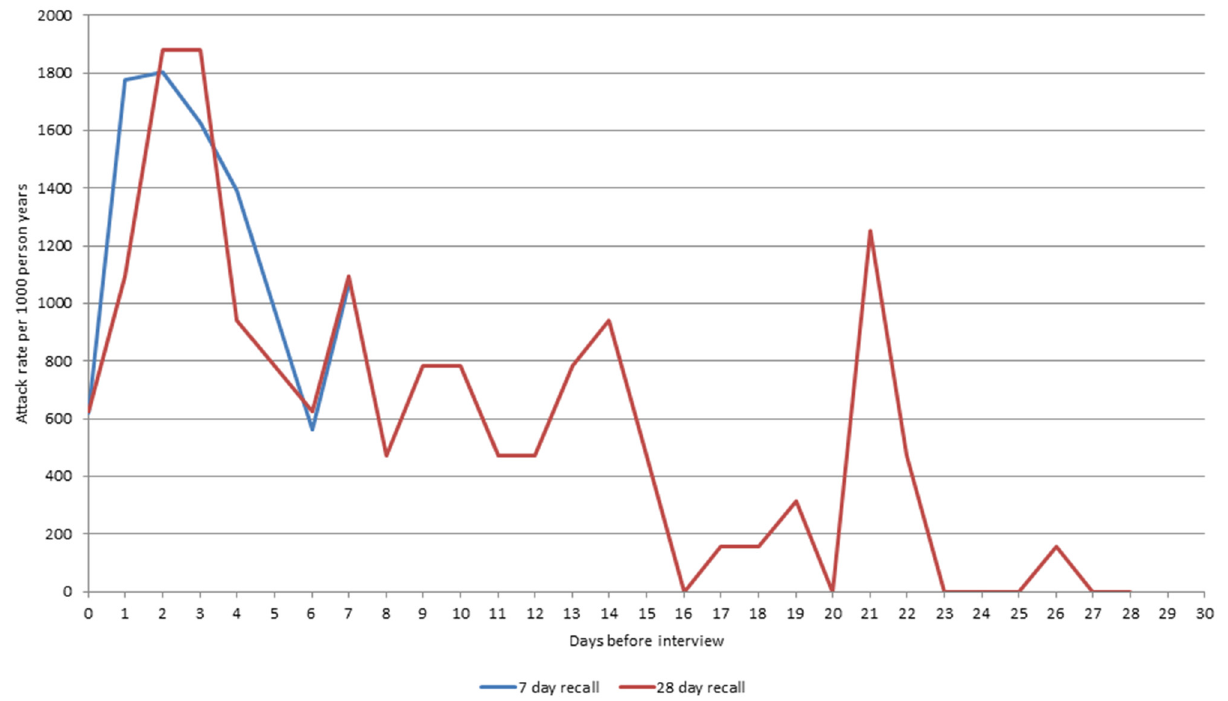
Fig 2. Decay in the reporting of symptoms among telephone survey participants by recall group a . a Each data point represents the calculated crude annual incidence rate based on the number of participants reporting onset of symptoms on day of interview (x = 0) and each day prior to the date of